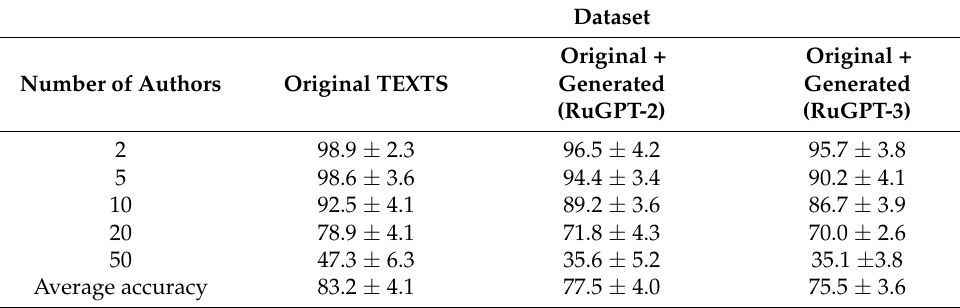
Table 8. Best FS method + generated texts.